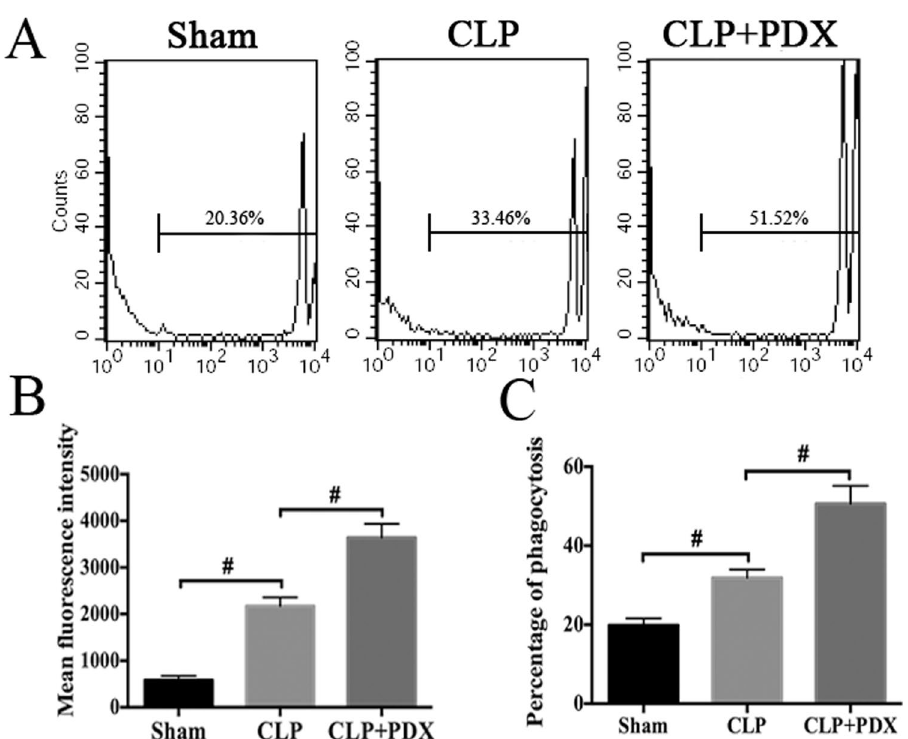
Figure 5. PDX improved phagocytic capability of peritoneal macrophage from septic mice. Peritoneal macrophages were collected 24 h after CLP and incubated with carboxylate-modified microspheres for 1 h and the samples were analyzed by flow cytometry. ( A ) Representative image for each group. The mean fluorescence intensity ( B ) and the percentage of phagocytosis ( C ) were quantified with flow cytometry analysis. Data are presented as mean ± SEM (n = 6). # P <